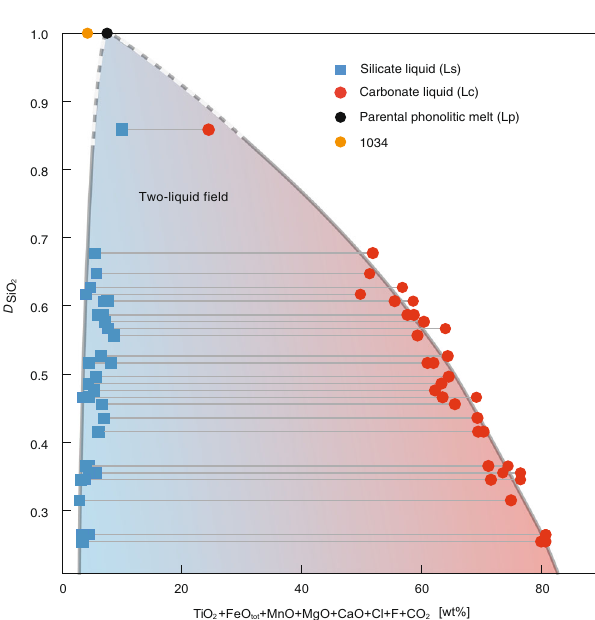
Fig. 4 Major element distribution between immiscible silicate and carbonate liquids. Partition coef fi cients ( D Ls/Lc ) for major element oxides between immiscible silicate and carbonate liquids in hauyne-entrapped melt inclusions. Mg, Ca, Mn, Fe, F, Ti, and Cl partition into the carbonate melt while Na, K, Al, Si, S are concentrated in the silicate liquid. In general our data agrees well with experimental data from Kjarsgaard 37 on carbonated nephelinite at 200 MPa and 900 – 960 °C and natural data from Guzmics et al. 22 on heated perovskite-hosted coexisting immiscible melt inclusions from nephelinitic rocks (Kerimasi volcano) indicating that equilibrium between the immiscible melts has been attained. All Fe is shown as FeO tot